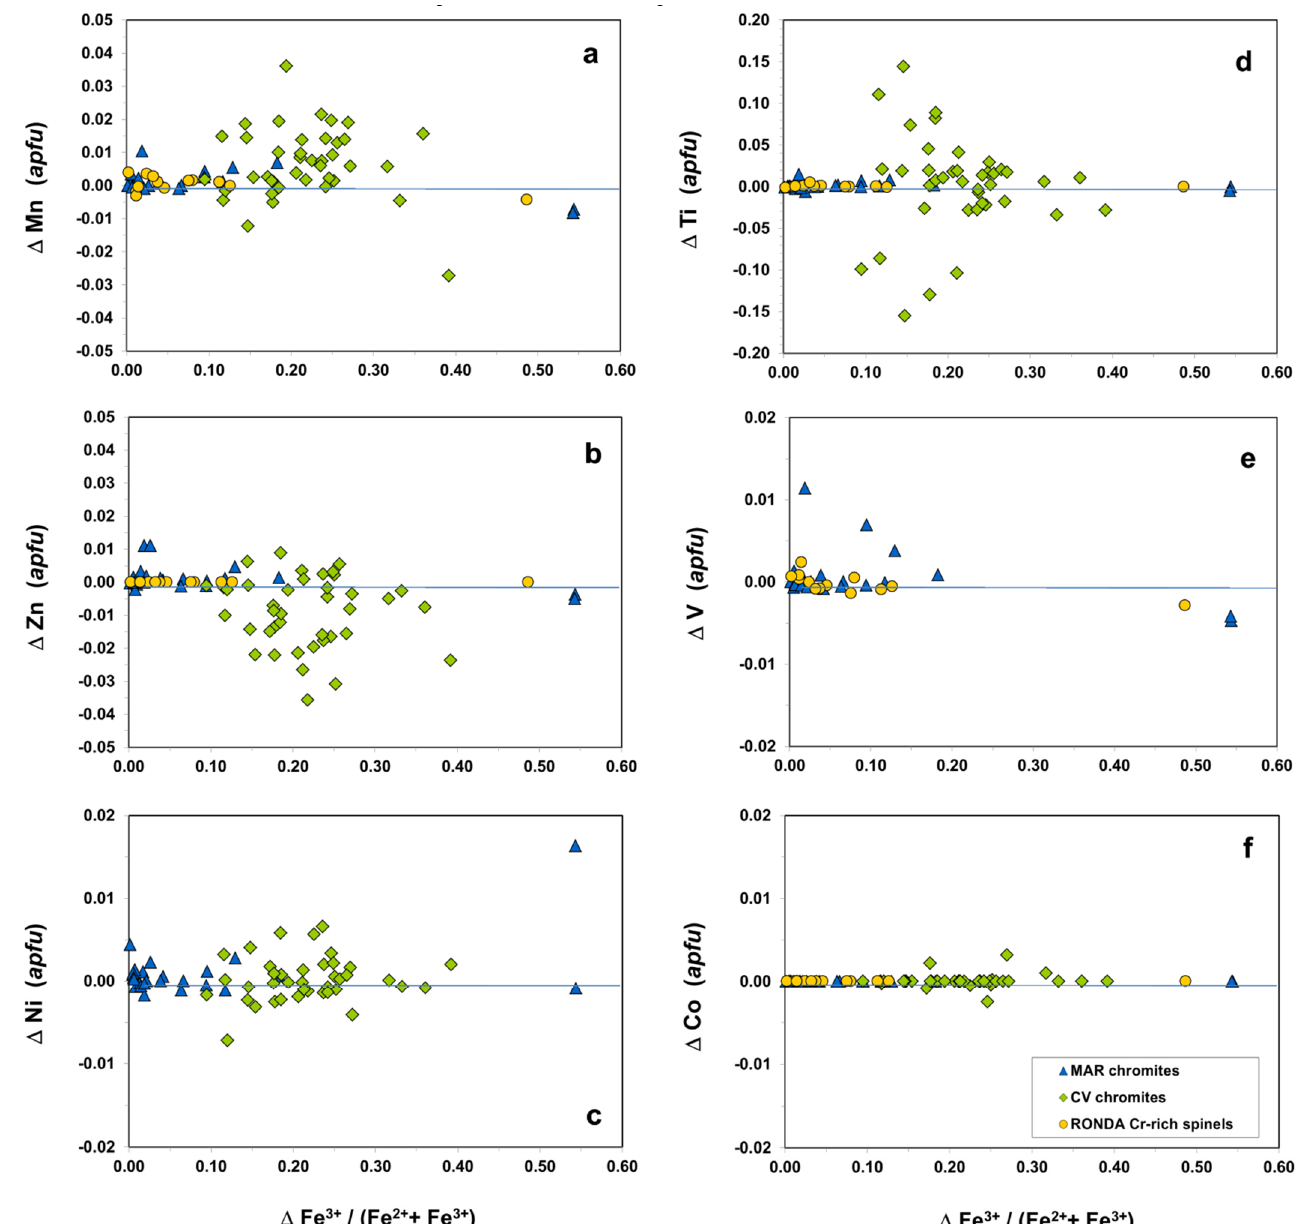
Figure 12. Variation of trace components ( a ) Ti, ( b ) V, ( c ) Mn, ( d ) Ni, ( e ) Zn and ( f ) Co with increasing Fe oxidation rates in the MAR magnesiochromites, CV chromites and Ronda chromian spinels.